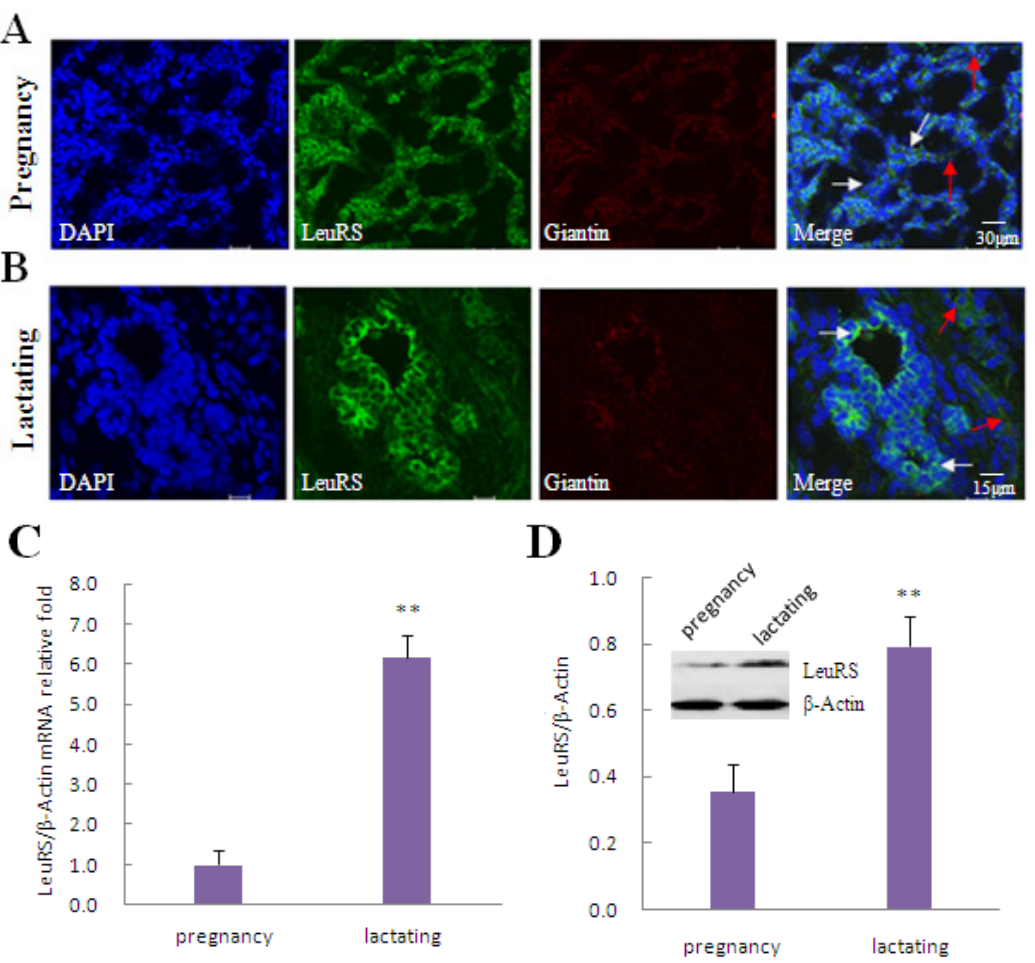
Figure 1. Localization and expression of LeuRS in mammary gland tissue and DCMECs. ( A , B ). Localization of endogenous LeuRS in pregnancy ( A ) and lactating ( B ) mammary glands. LeuRS were counterstained with FITC, giantin as a protein localized in the Golgi apparatus were counterstained with Cy5, and nuclei were counterstained with 4',6-diamidino-2-phenylindole (DAPI). Red arrows indicated LeuRS expressed in the connective tissues while white arrows designated LeuRS expressed in the acinar buds. Scale bars: 30 and 15 μ m, respectively. Representative images from one of three or more independent experiments; ( C ) Relative levels of LeuRS mRNA in pregnancy and lactating mammary gland tissues as determined by qRT-PCR; ( D ) Levels of LeuRS protein in pregnancy and lactating mammary gland tissues as determined by western blotting analysis. β -Actin was assessed as a loading control. A representative blot and quantitation of three independent experiments were shown. In all panels, data represent the mean ± SD of three independent experiments. ** p <